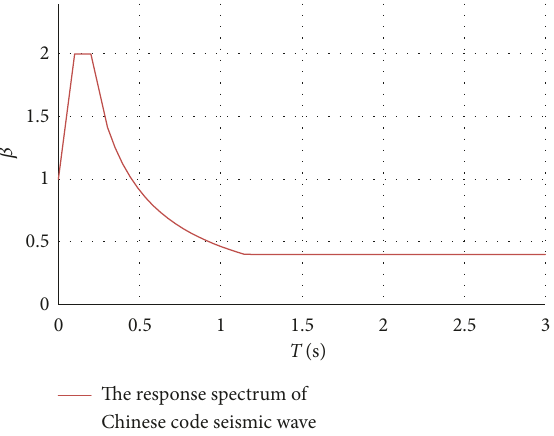
Figure 10: Inputting Chinese Code seismic wave.